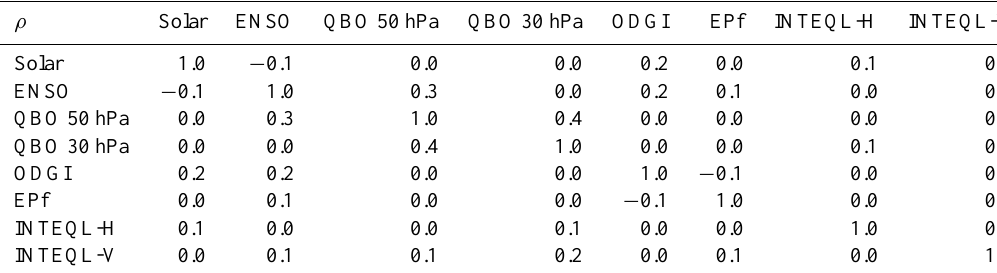
Table 2. Correlations coefficients at TMF between proxies with QBO @ 50hPa and 30hPa. ρ